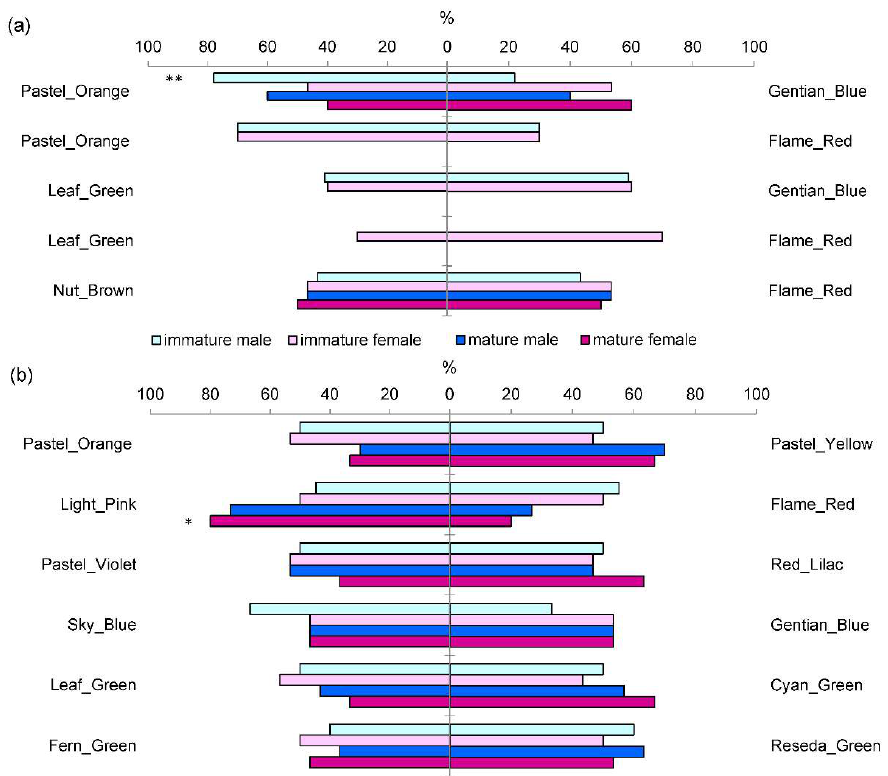
Figure 3. Percentage of immature and mature M. galloprovincialis beetles that responded to one of the compared pairs of ( a ) contrasting colors and ( b ) closely related colors under laboratory conditions; *, ** indicate significant differences from the 50%:50% ratio with p < 0.05 and p < 0.01, respectively (tested with the 𝜒 2 test for 2 × 2 contingency tables using numbers of beetles provided in Supplementary Materials Table S1).